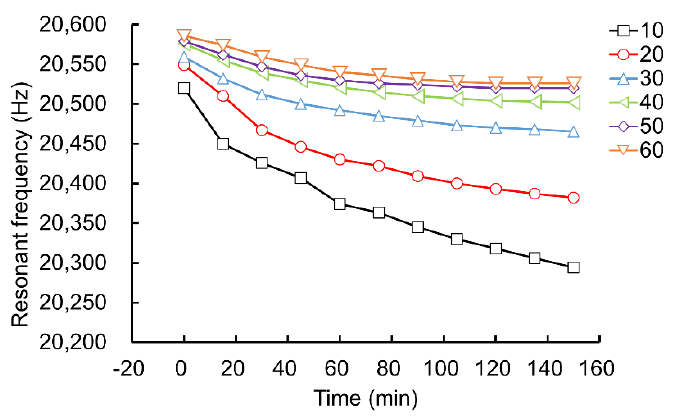
Figure 9. Effect of Preload Torque of Ultrasonic Horn on Resonance Frequency Drift of Acoustic Vibration Component.